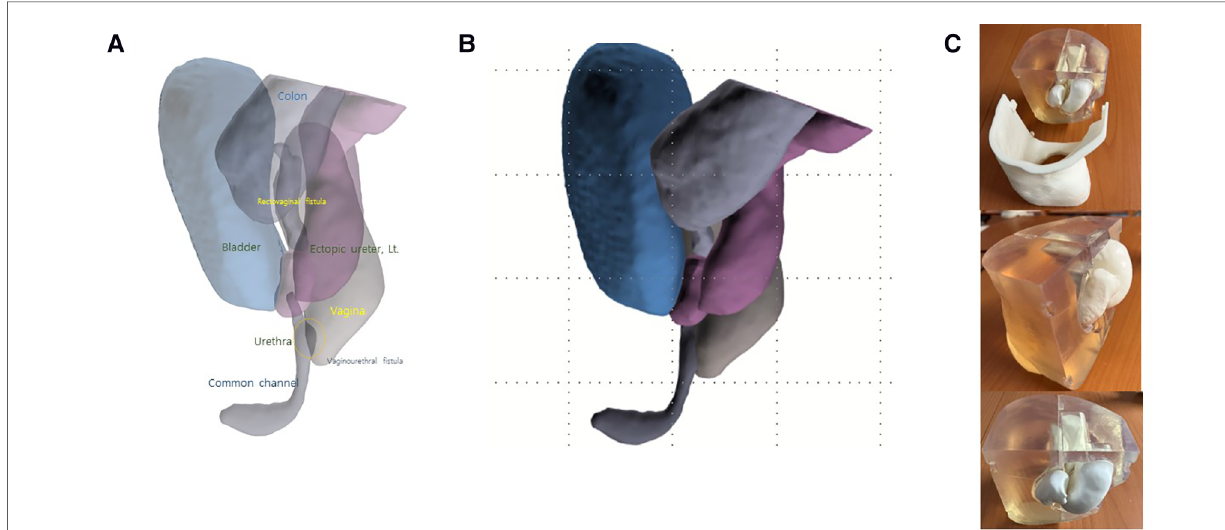
FIGURE 2 Three-dimensional (3D) reconstruction images ( A , B ) and printing ( C ) of the cloaca in the present case.Each structure ( A , B ) and their spatial relationship in the pelvic cavity ( C ) can be identi fi ed using 3D reconstruction. The length measured from 3D reconstruction was compared that measured by endoscopy. Urogenital separation was performed based on common channel and urethral lengths determined from 3D reconstruction images. 3D reconstruction images suggested the requirement for vaginal reconstruction. Thus, vaginal substitution using a dilated rectum was performed.